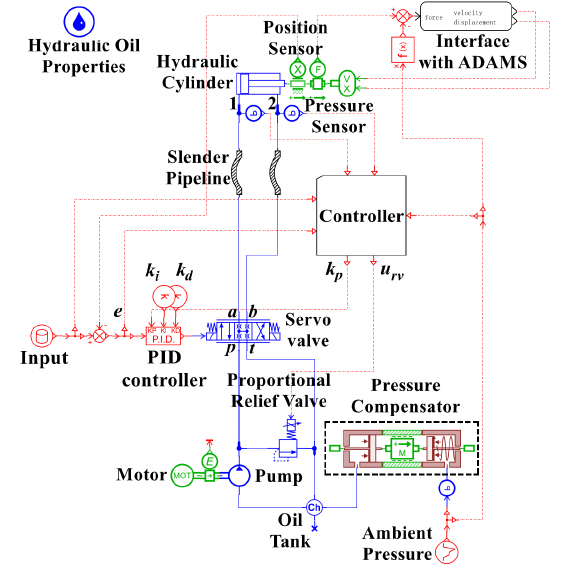
Figure 5. AME Sim model of hydraulic system and control strategy.